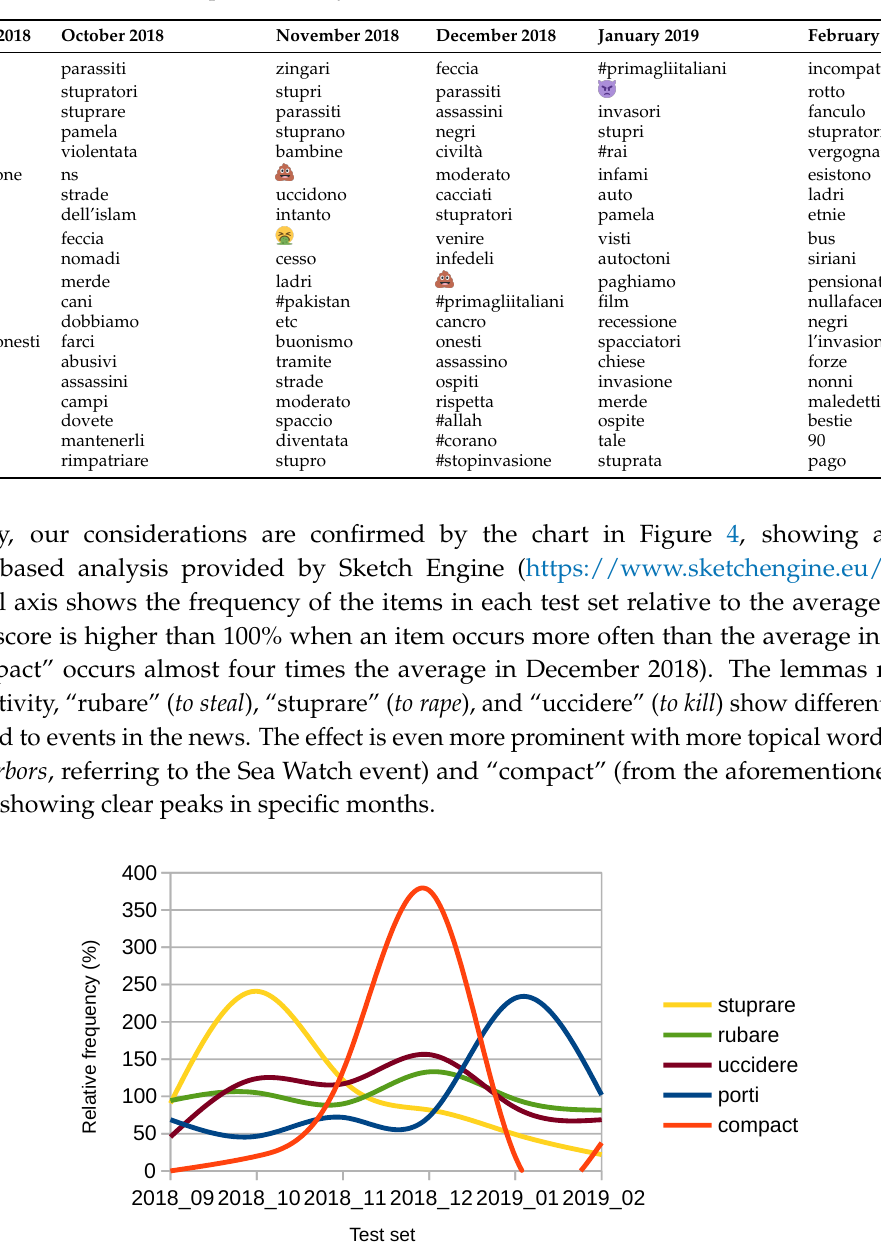
Table 11. Top 20 words by Polarized Weirdness Index in each test set.